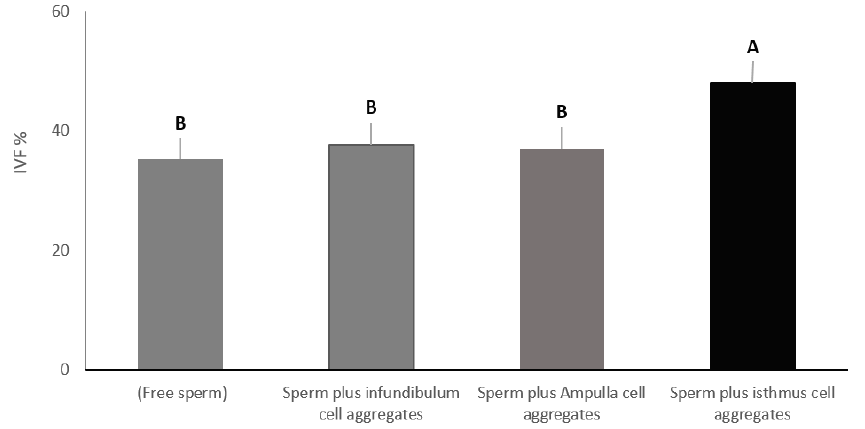
Figure 3. Cell aggregates from different oviduct segments (infundibulum, ampulla, and isthmus) were allowed to bind sperm. Mature COCs were added to all groups and co-cultured for in-vitro fertilization. Columns with different letters are significantly different ( p < 0.01).